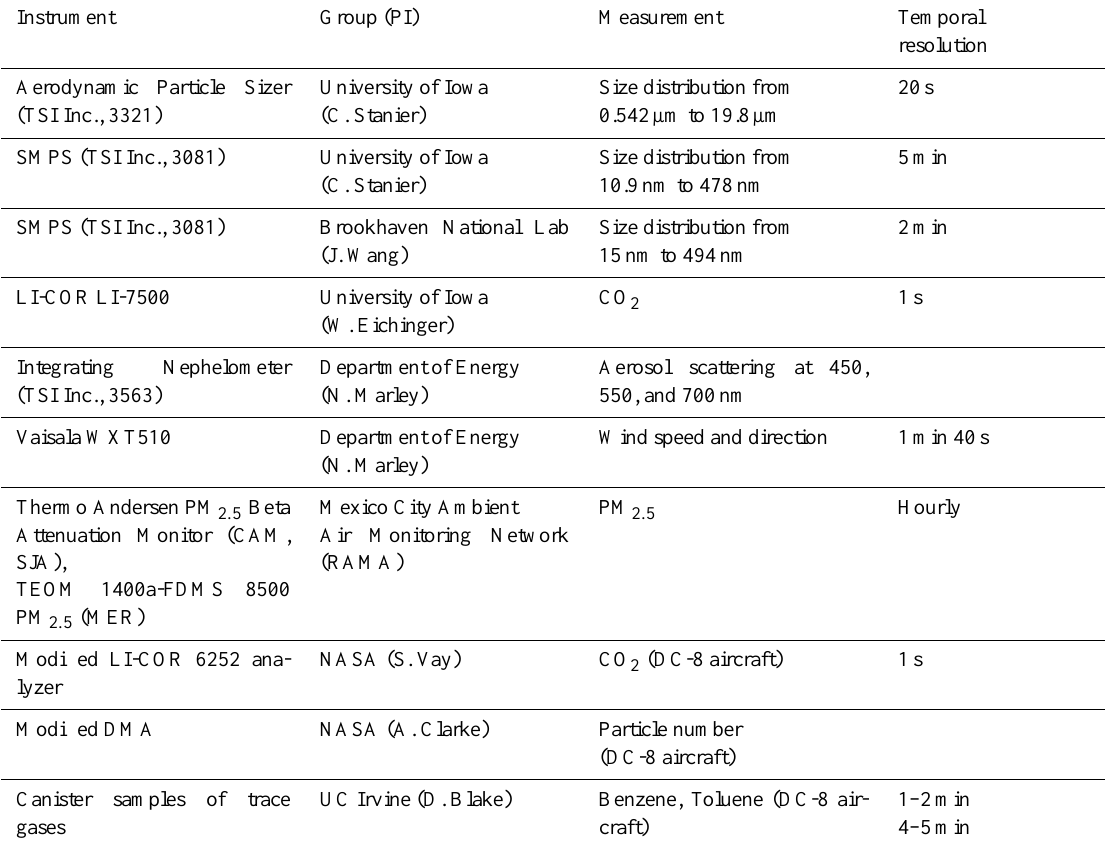
Table 1. Measurements used in the data analysis for this work.